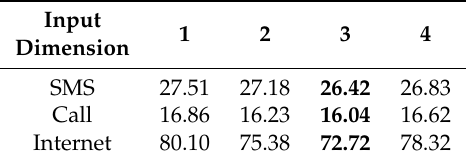
Table 3. RMSE results of different input dimensions.